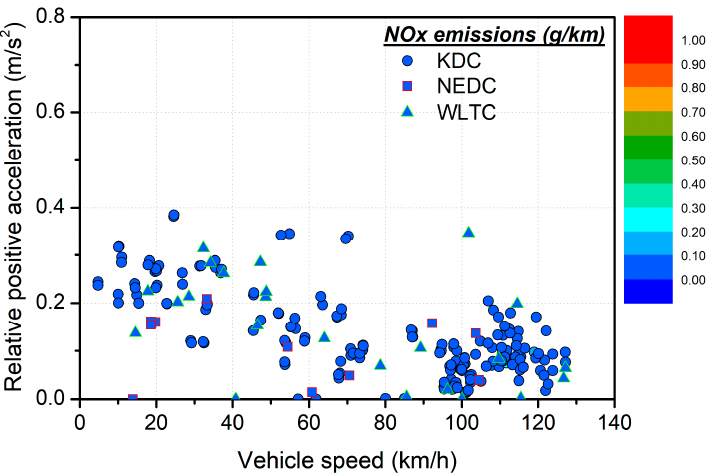
Figure 8. NOx emissions according to vehicle speed and relative positive acceleration of the labor- atory Korea Driving Cycle (KDC)